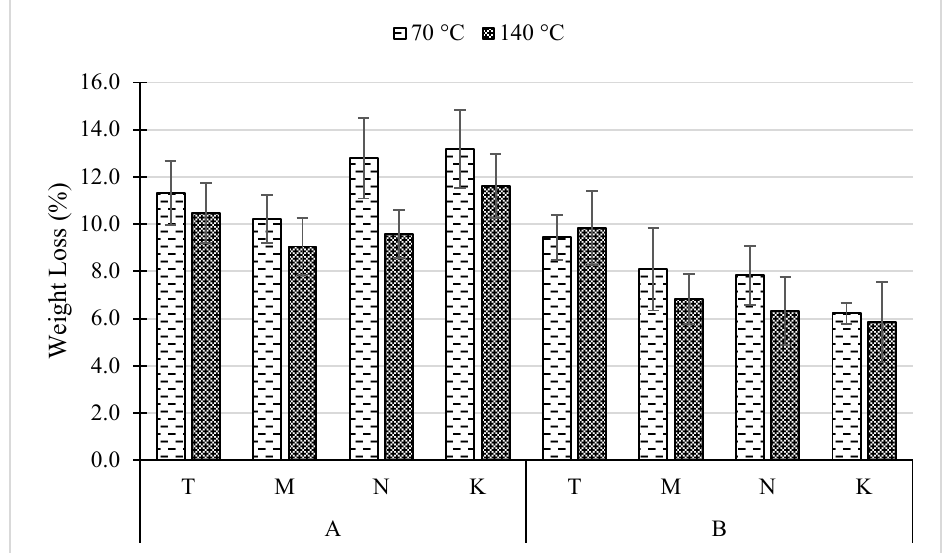
Figure 5. Weight loss of manii wood in the decay test after heating at 70 or 140 ◦ C and treatments with boric acid (B), without boric acid (A), with neem oil (M), with tamanu oil (N), with candlenut oil (K), and without oil